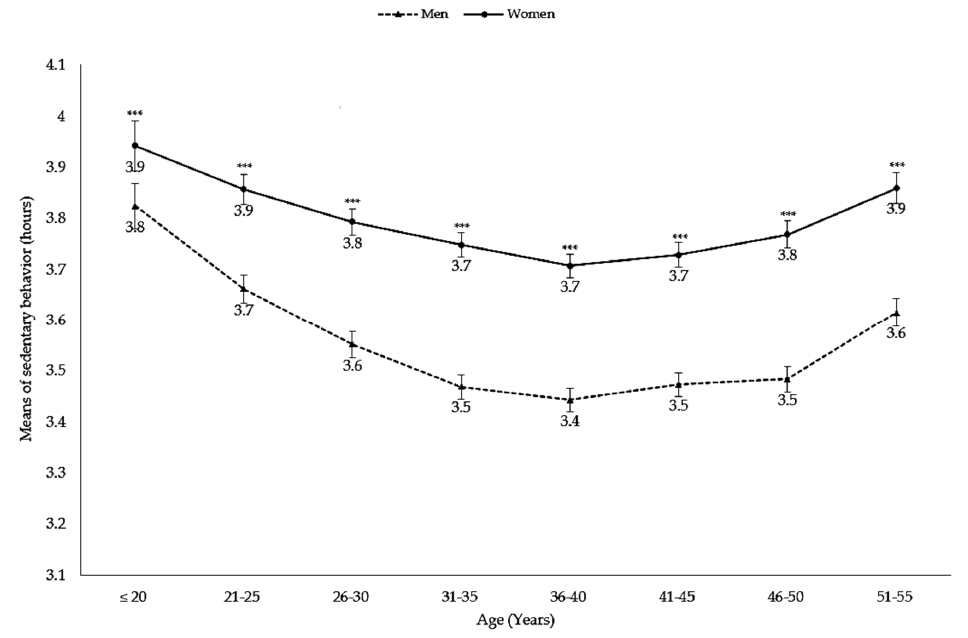
Figure 4. Mean hours of sedentary behaviors by age. Footnote: ***: p < 0.0001.